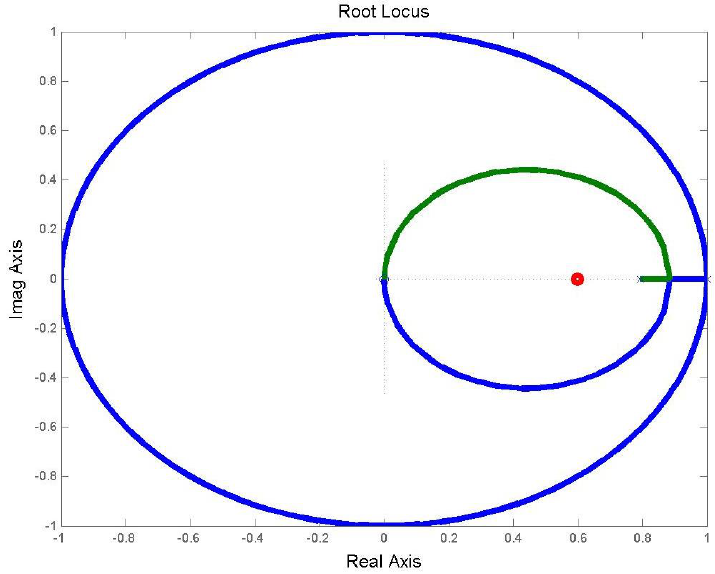
Figure 4. Root locus for the DFBCP